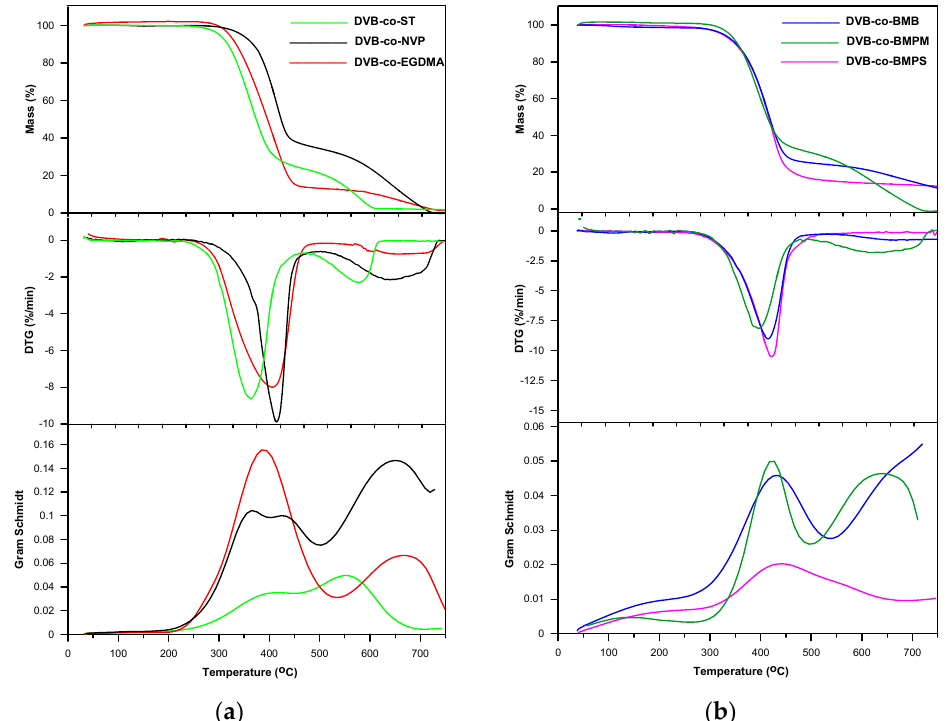
Figure 5. TG, DTG and Gram–Schmidt curves of copolymers obtained under helium atmosphere. ( a ); DVB- co -ST, DVB- co -NVP and DVB- co -EGDMA; ( b ) DVB- co -BMB, DVB- co -BMPS and DVB- co -BMPM.